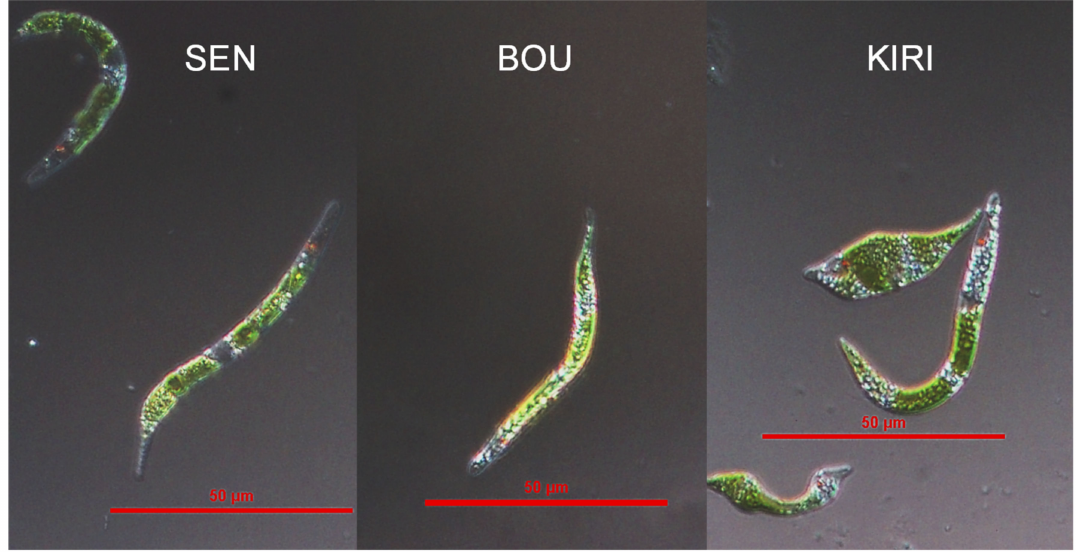
Figure 1. Upright light microscope micrographs of the Euglena mutabilis strains—SEN, BOU, and KIRI. Scale bars indicate 50 µ